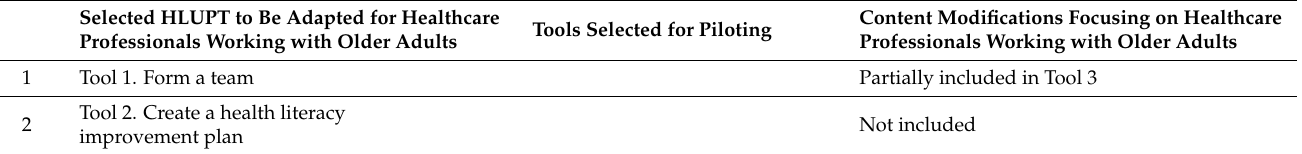
Tools Selected for